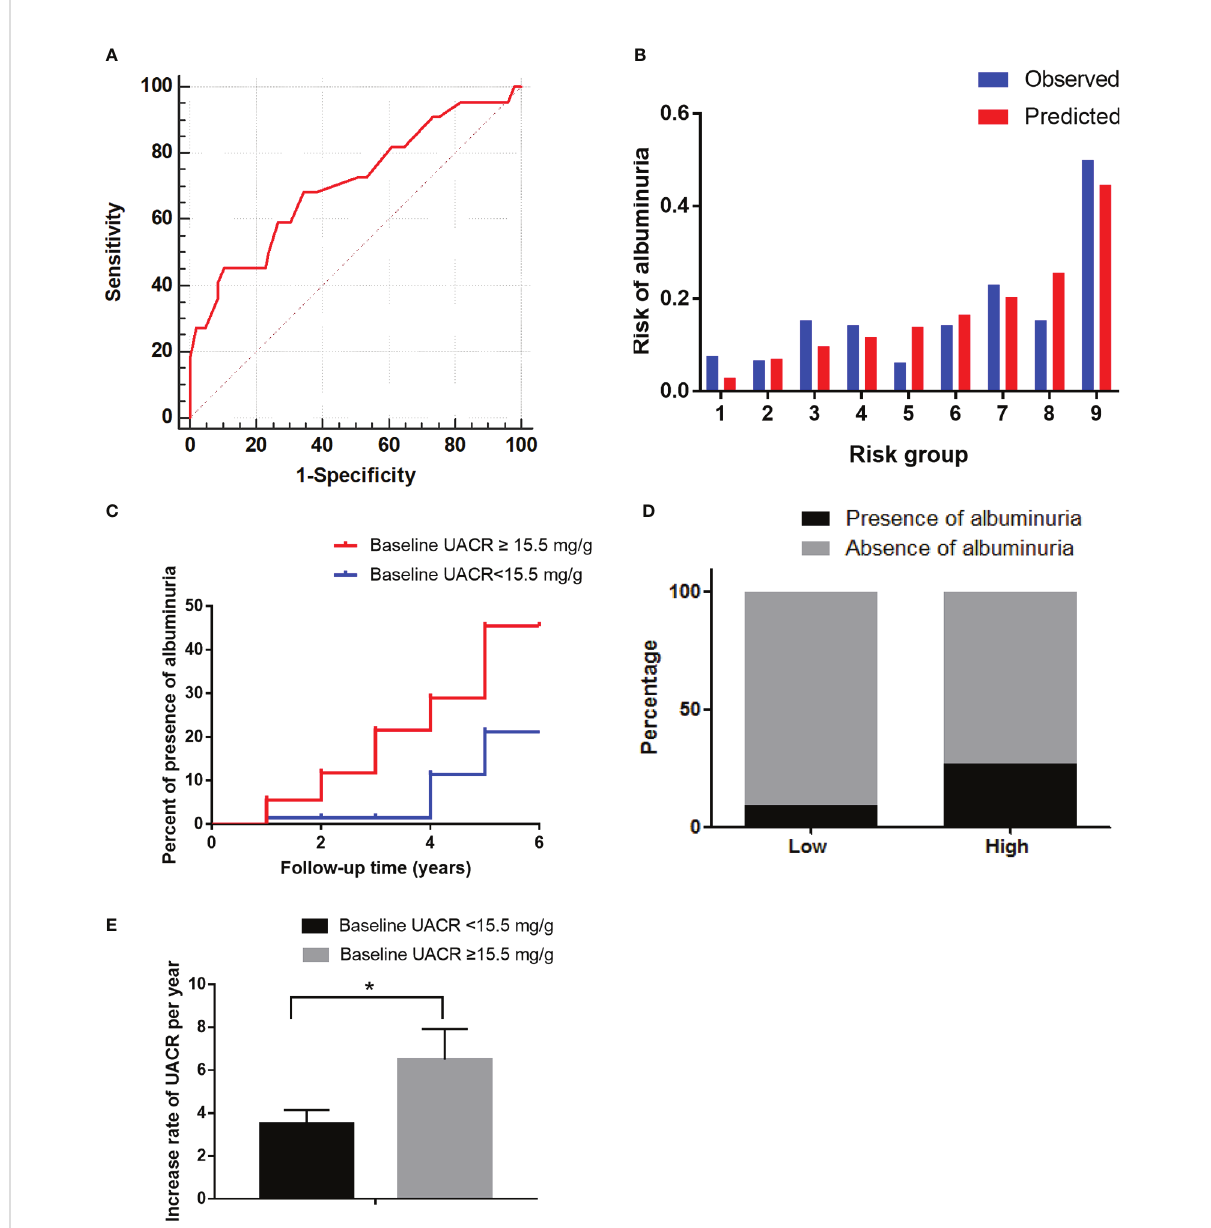
FIGURE 5 The performance of the baseline UACR in predicting albuminuria and baseline eGFR in predicting reduced eGFR in the validation cohort. (A) : Receiver operating characteristic curve of baseline UACR in predicting albuminuria. The area under the curve (AUC) and its 95% CI were 0.71(0.58- 0.84). The sensitivity and speci fi city were 0.68 and 0.66, respectively, at 15.5mg/g of UACR. (B) : Hosmer-Lemeshow (H-L) test for the calibration of the baseline UACR (P=0.95). (C) : Kaplan-Meier curve of albuminuria end point for the low-risk (UACR < 15.5 mg/g) and high-risk (30 > UACR ≥ 15.5 mg/g) groups. The HR (95% CI) was 2.78 (1.31-9.28) (P = 0.035) in the high-risk group. (D) : Prevalence of albuminuria in the two risk groups. (E) : The increase rate of UACR per year in the low-risk (UACR < 15.5 mg/g) and high-risk groups (30 > UACR ≥ 15.5 mg/g) according to the cut-off value. * P <